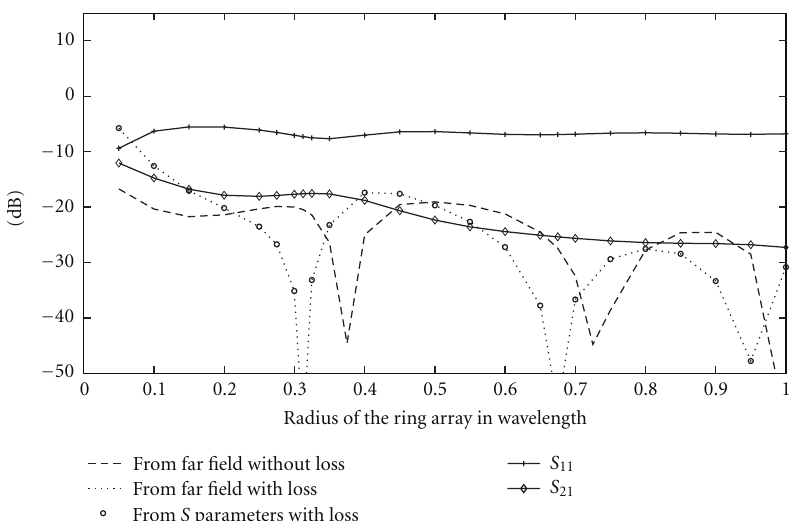
Figure 5: The computed spatial envelope correlations and scattering parameters between dipoles 1 and 2 versus their separation distance, in a MIMO system of three elements, arranged in a ring array.